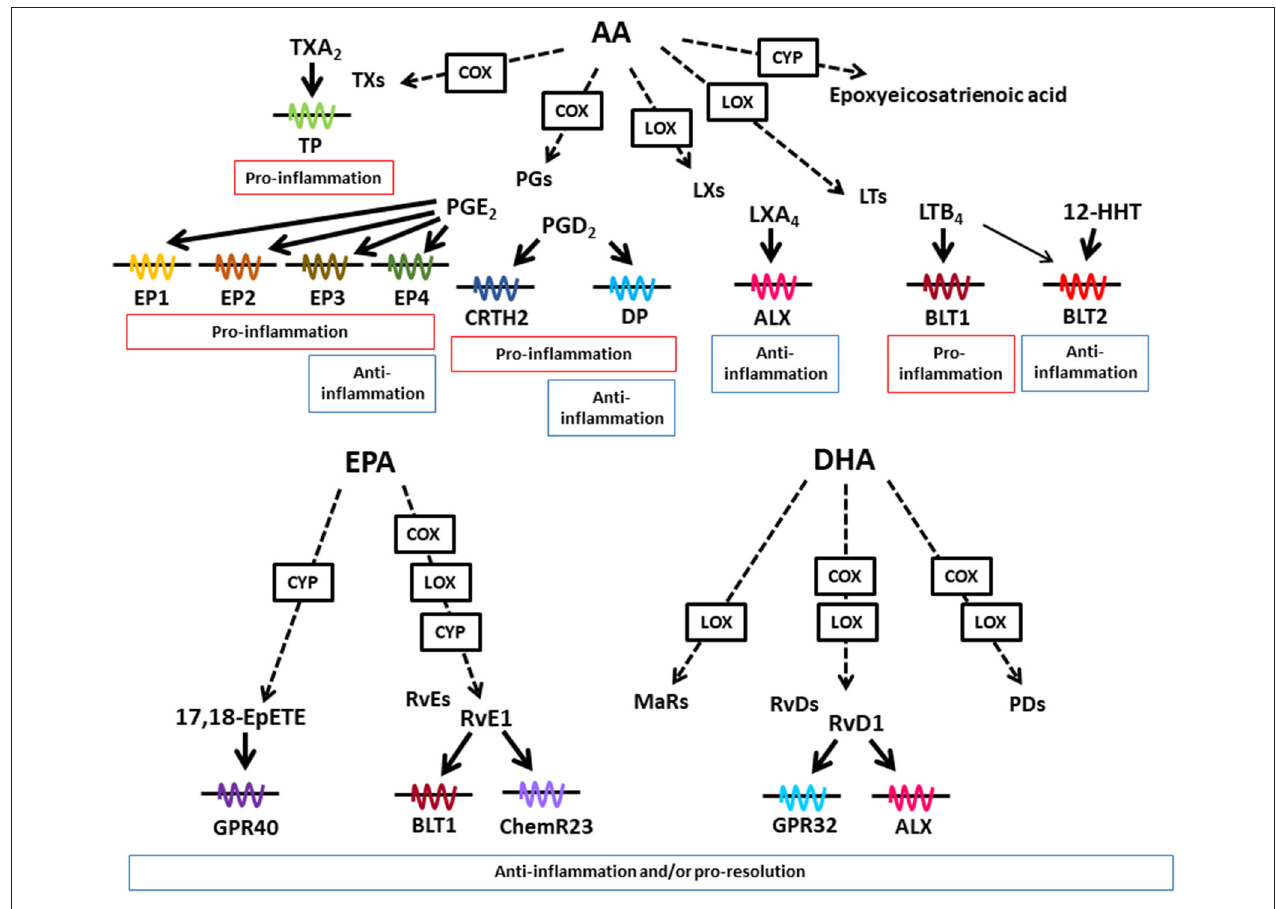
FIGURE 1 | Lipid mediators derived from AA, EPA, and DHA. Various kinds of lipid mediators are produced from ω 6- and ω 3-PUFAs. AA, EPA, and DHA are converted to bioactive lipid mediators by the enzymatic activities of COX, LOX, and CYP. Lipid mediators exert their biological effects through binding to G-protein-coupled receptors. AA-derived lipid mediators have pro- and anti-inflammatory activities, whereas EPA- and DHA-derived lipid mediators exert anti-inflammatory or pro-resolution activities or